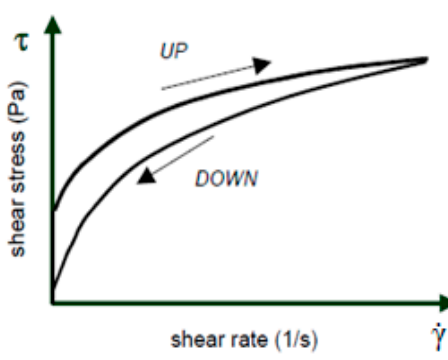
Figure 3. Illustration of thixotropic behavior.